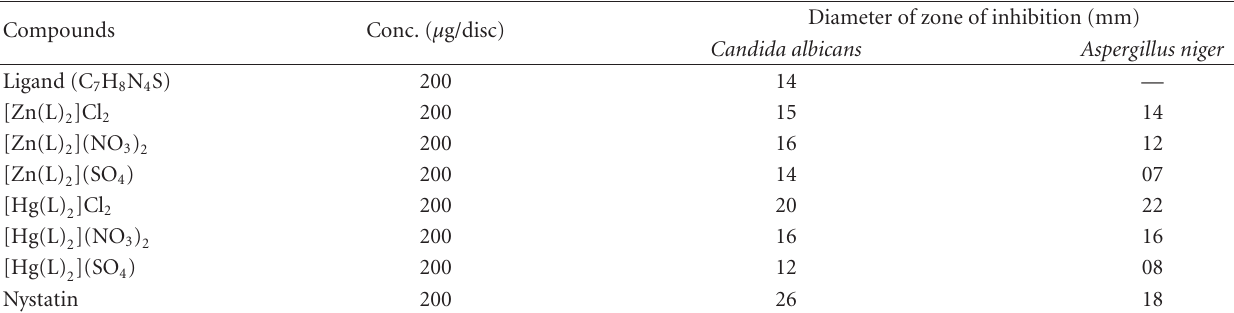
Table 4: Antifungal screening data of the ligand and its Zn(II) and Hg(II) complexes.